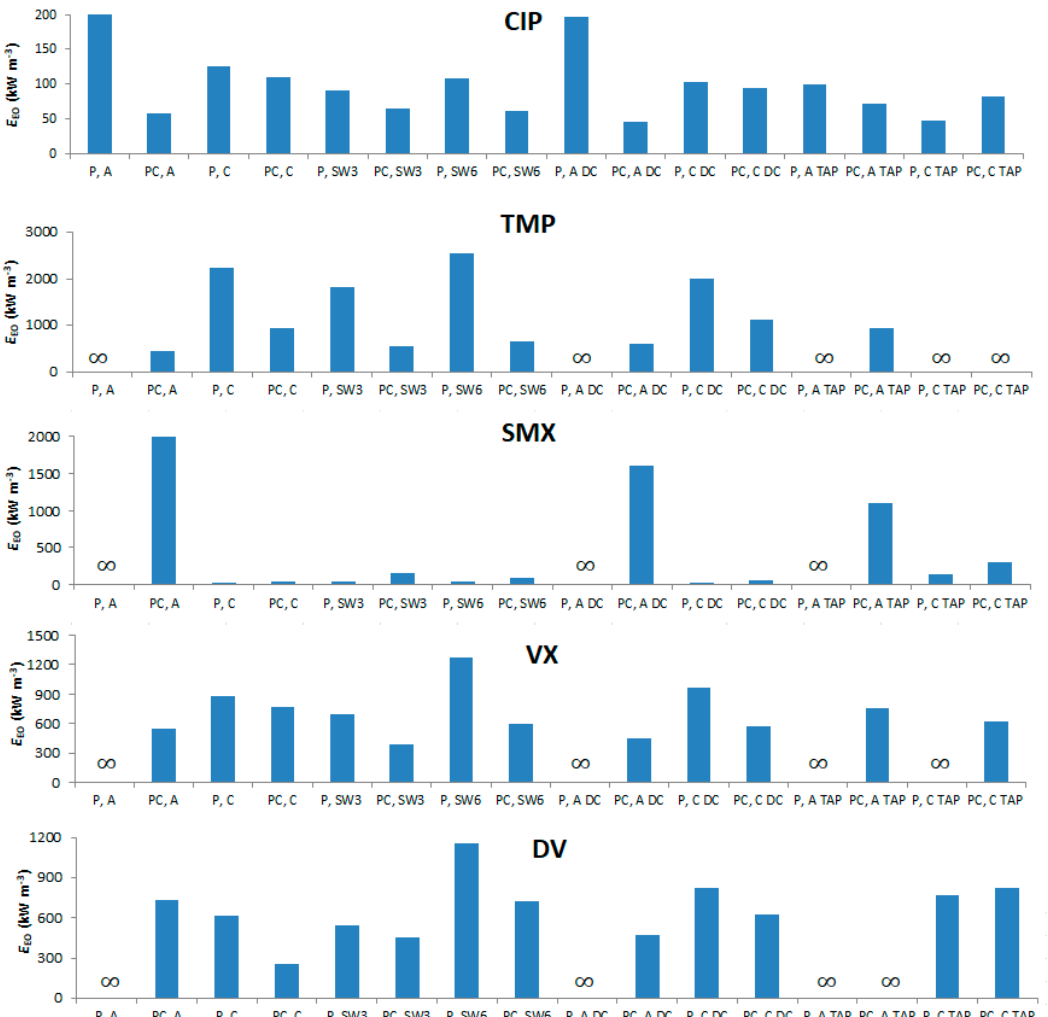
Figure 11. E EO values for the five PhACs for different processes. Experiments performed on MQ water, except the ones labelled with “tap” (tap water). Experiments performed under continuous illumination, except the ones labelled with “DC“ (duty cycle =